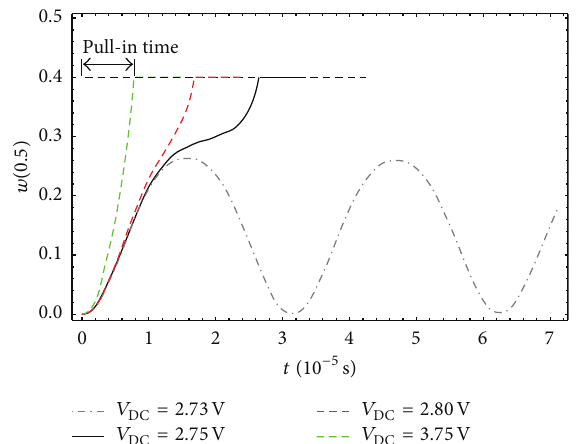
Figure 3: Transient response of the microswitch for different applied DC voltages.